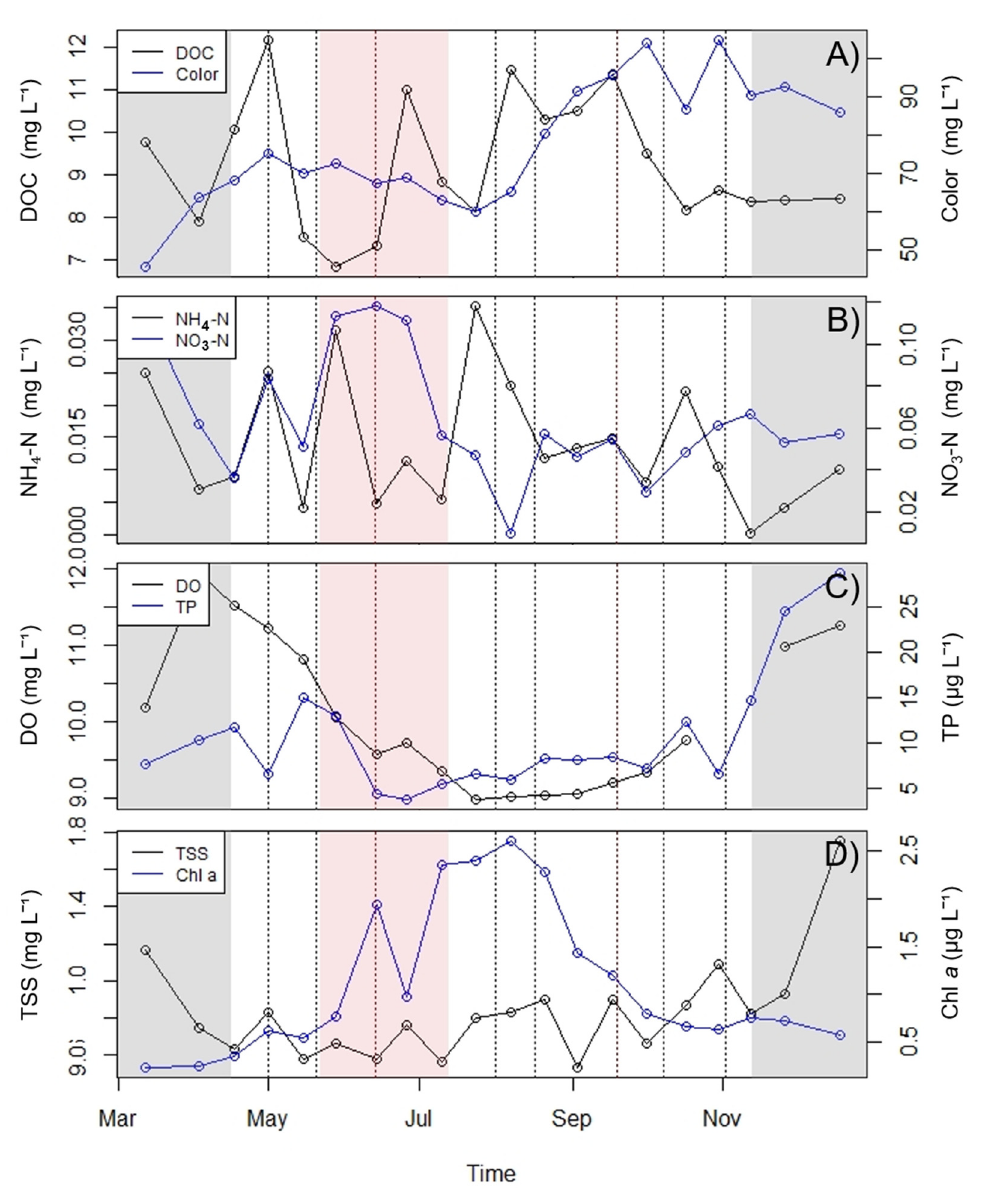
Figure 3. Nutrients recorded in 2018: ( A ) Lough Feeagh DOC and color, ( B ) Lough Feeagh average NH 4 -N and NO 3 -N, ( C ) average daily dissolved oxygen (DO) and total phosphorus (TP), and ( D ) total suspended solids (TSS) and Chlorophyll a (Chl a ). Shaded grey areas indicate dates outside the study period. Dotted vertical lines represent weather events. The pale red shaded area indicates the drought period.